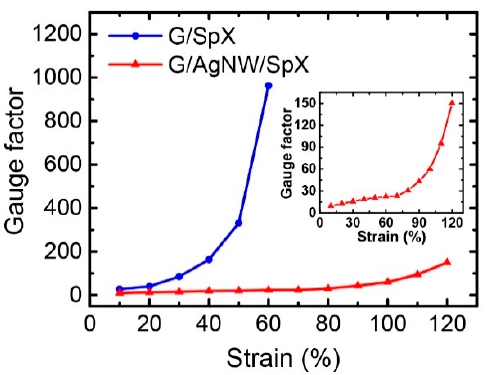
Figure 6. GFs of the G/SpX and G/AgNW/SpX composite strain sensors. The inset shows the detailed GF of the G/AgNW/SpX sensor.